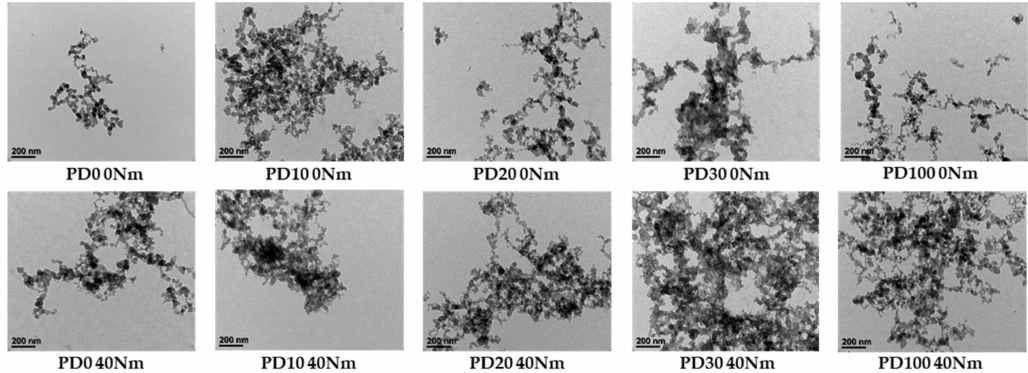
Figure 9. TEM images for various test fuels and engine loads (pilot BTDC 20 ◦